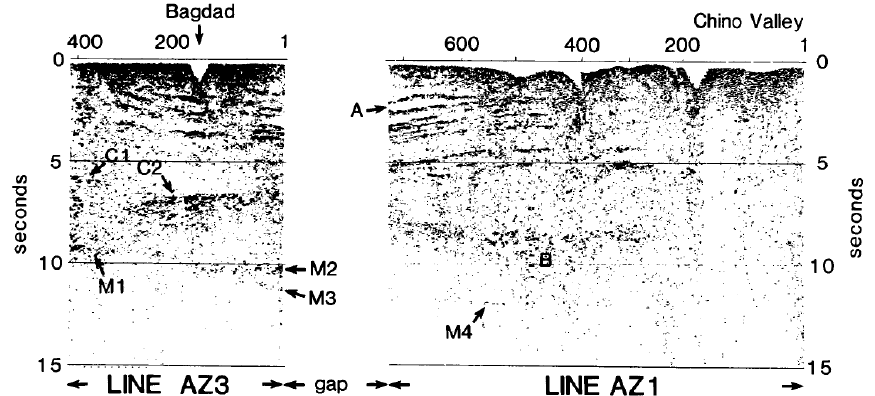
Figure 5. Prominent layered reflections (A) traced by the COCORP seismic reflection profiles in central Arizona [57]. Seismic modeling of mafic intrusions exposed nearby, together with the similarity in reflection character to the Siljan Ring reflectors, supports the interpretation of this sequence as also due to mafic intrusion [58]. The deeper reflections (C, B) may mark still-fluid magma. M indicates possible Moho